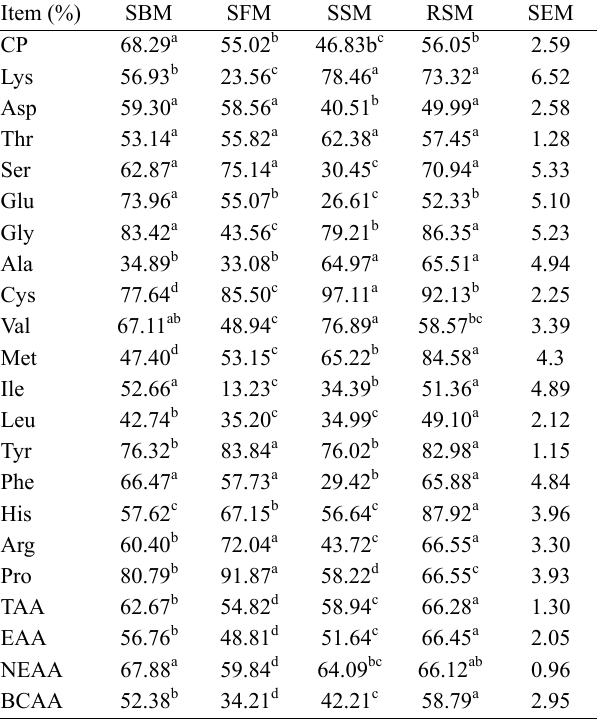
Table 5. Rumen degradability of CP and amino acid of SBM, SFM, SSM and RSM (16 h)